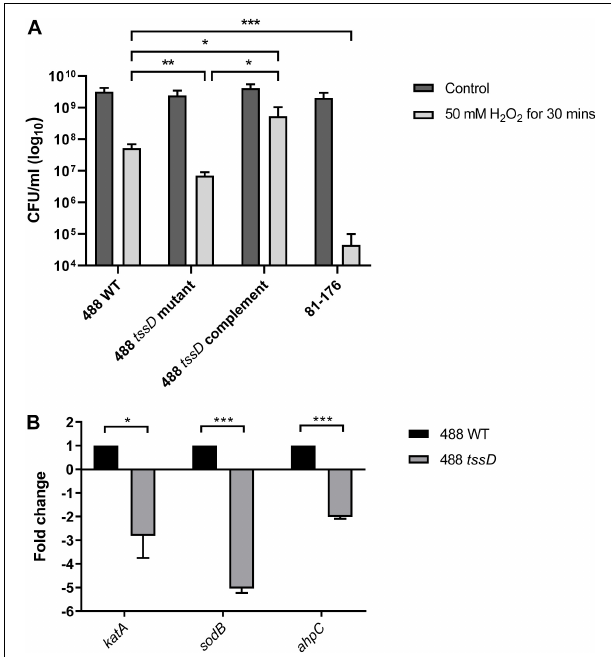
FIGURE 4 | Type VI secretion system of C. jejuni is involved in the oxidative stress response. (A) Survival of 488 wild-type strain, 488 tssD mutant, 488 tssD complement, and 81–176 wild-type strain following exposure to oxidative stress. The strains were exposed to 50 mM H 2 O 2 for 30 min, then serial dilutions were performed and CFUs/ml counted. Asterisks denote a statistically significant difference ( ∗ p ≤ 0.05, ∗∗ p ≤ 0.01, ∗∗∗ p ≤ 0.001). (B) qRT-PCR analysis comparing expression of katA , sodB , and ahpC in the 488 wild-type strain and 488 tssD mutant. qRT-PCR analysis was performed using katA , sodB , and ahpC primers. Data was analyzed by the comparative CT method with gyrA housekeeping gene as the internal control. The relative expression of katA , sodB , and ahpC are shown. Asterisks denote a statistically significant difference ( ∗ p ≤ 0.05, ∗∗∗ p ≤ 0.001).